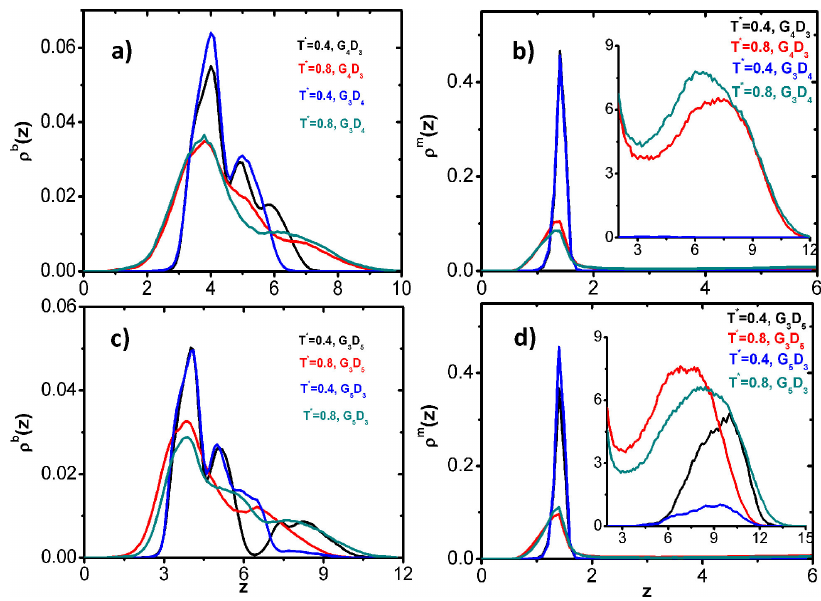
Figure 4. Calculated density profiles of the spherical beads ( a , c ) and the mesogens ( b , d ) of LCDrs under homeotropic the anchoring condition as a function of the distance z from the surface. The values of ρ m in the insets are scaled by 10 3